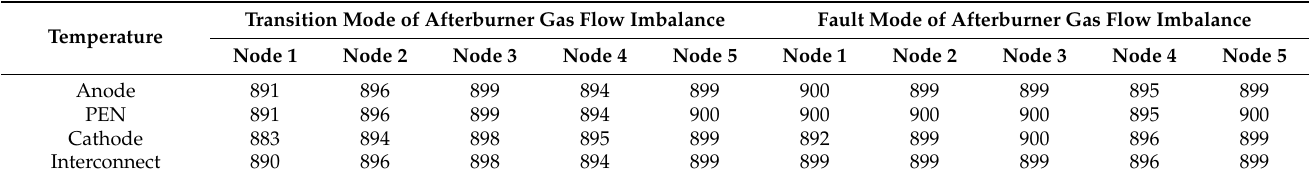
Table 9. Temperature distribution of SOFC stack nodes caused by the afterburner gas